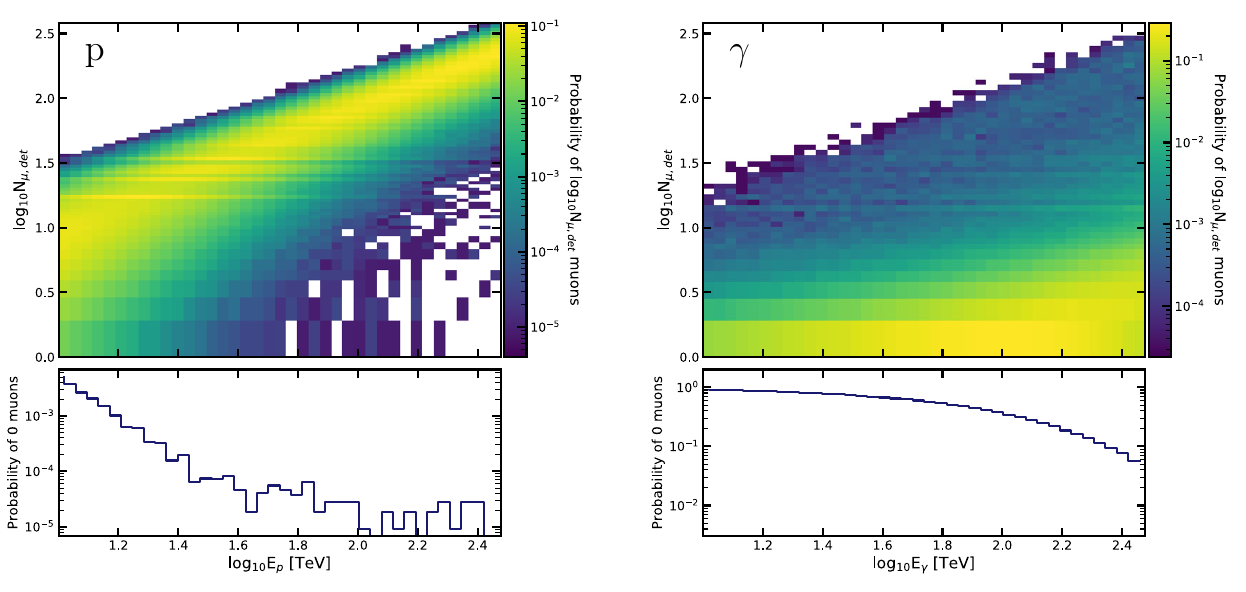
D T =28 m D T =12 m